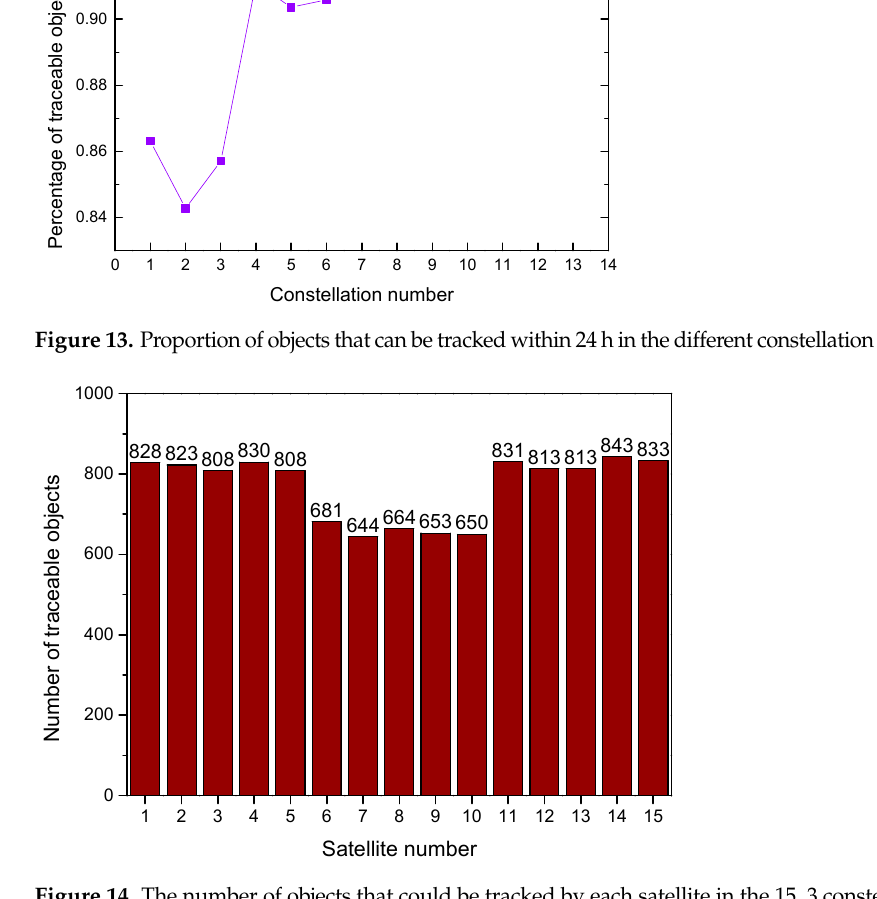
Figure 14. The number of objects that could be tracked by each satellite in the 15_3 constellation in 24 h.